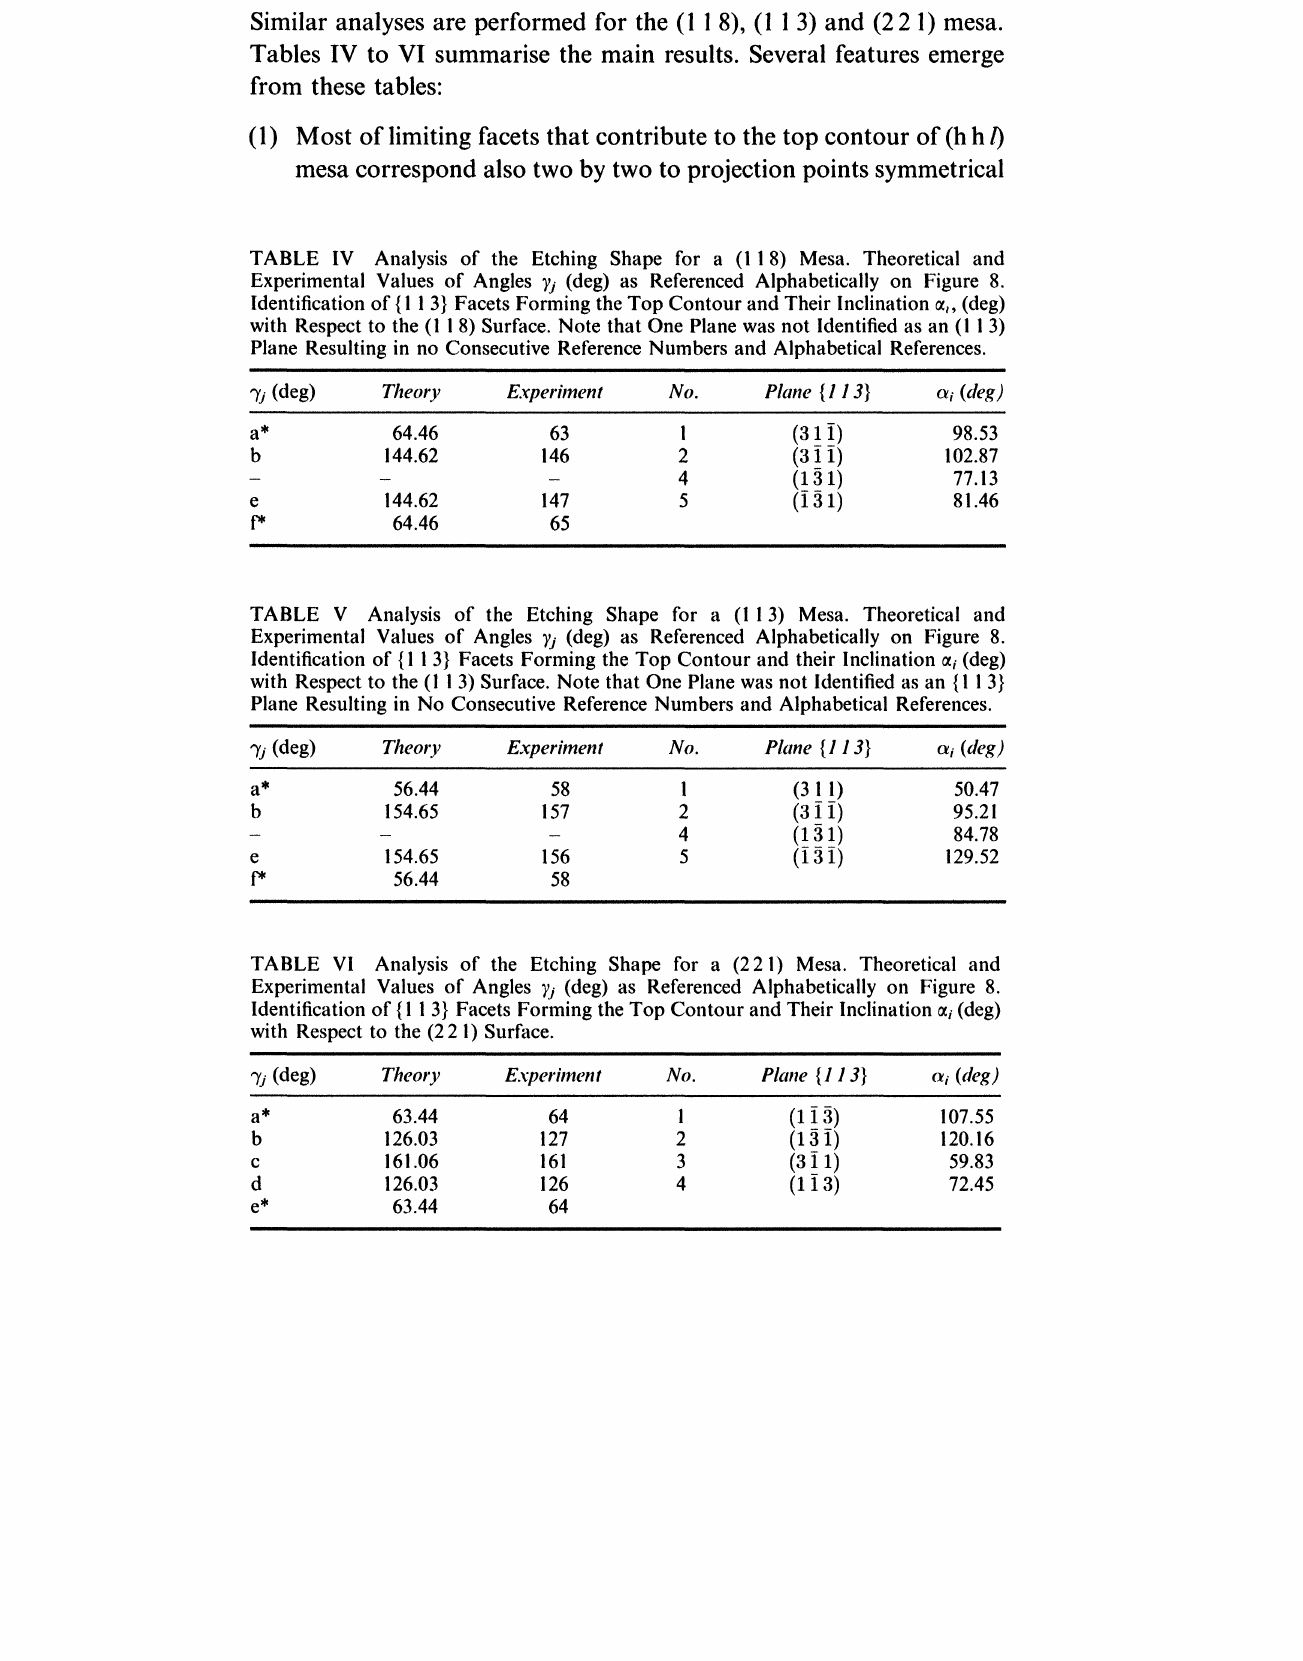
TABLE IV Analysis of the Etching Shape for a (l S) Mesa. Theoretical and Experimental Values of Angles Vj (deg) as Referenced Alphabetically on Figure 8. Identification of 3} Facets Forming the Top Contour and Their Inclination t,, (deg) with Respect to the (l 8) Surface. Note that One Plane was not Identified as an (I 3) Plane Resulting in no Consecutive Reference Numbers and Alphabetical References.